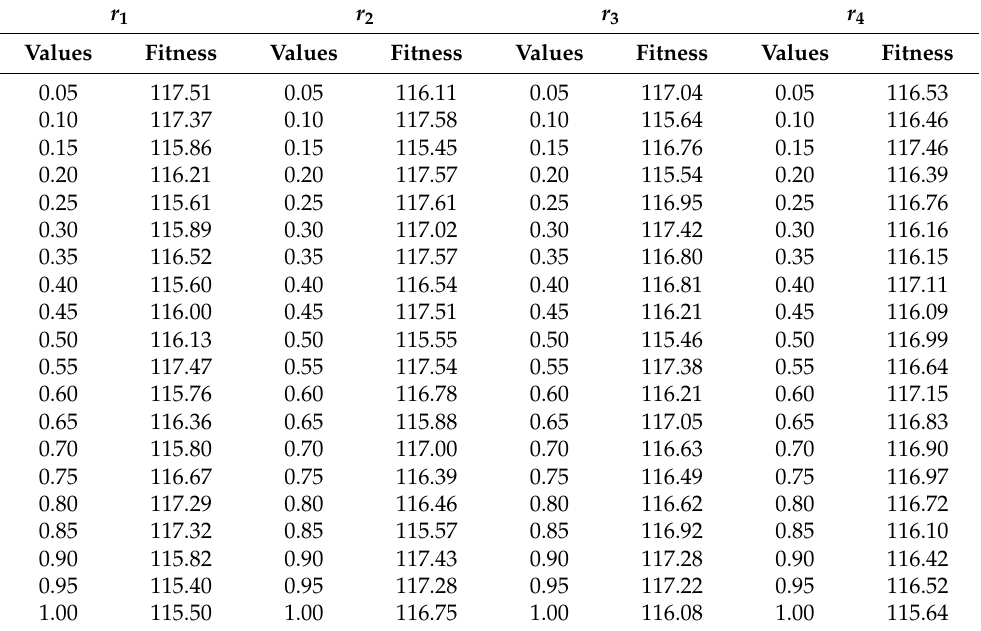
Table 15. Minimization results for different values of ADSCFGWO’s parameters